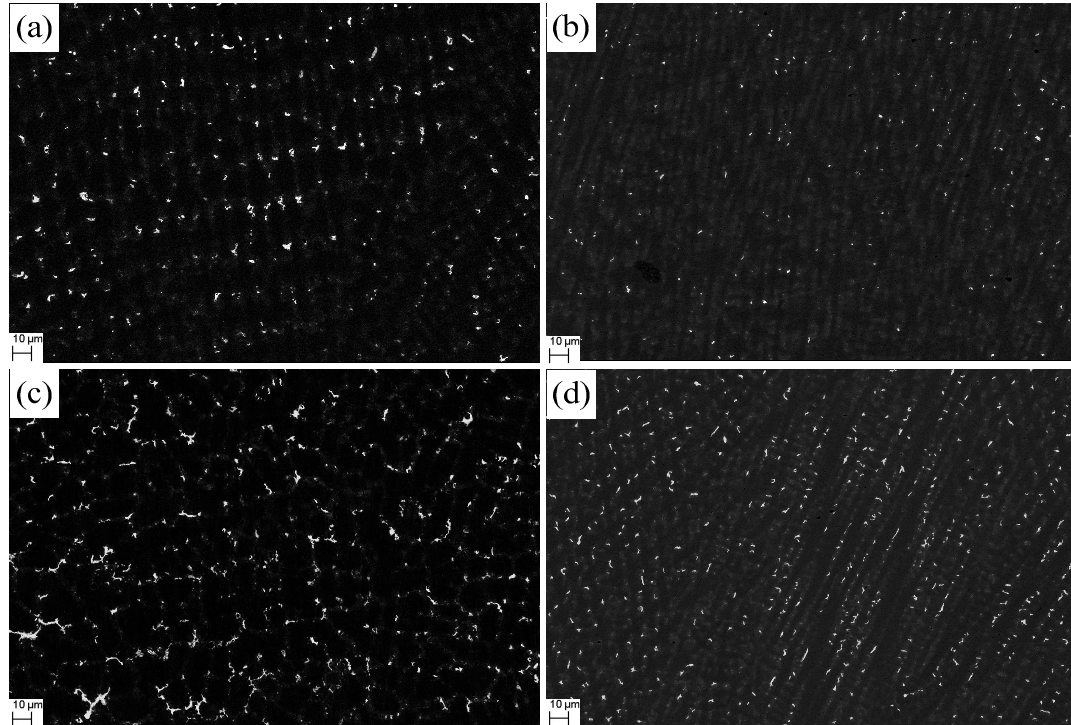
Figure 11. The morphology of Laves phase in the cladding layer: ( a ) in equiaxed interdendritic regions of No.1 alloy; ( b ) in columnar interdendriticregions of No.1 alloy; ( c ) in equiaxed interdendritic regions of No.2 alloy; ( d ) in columnar interdendritic regions of No.2 alloy.